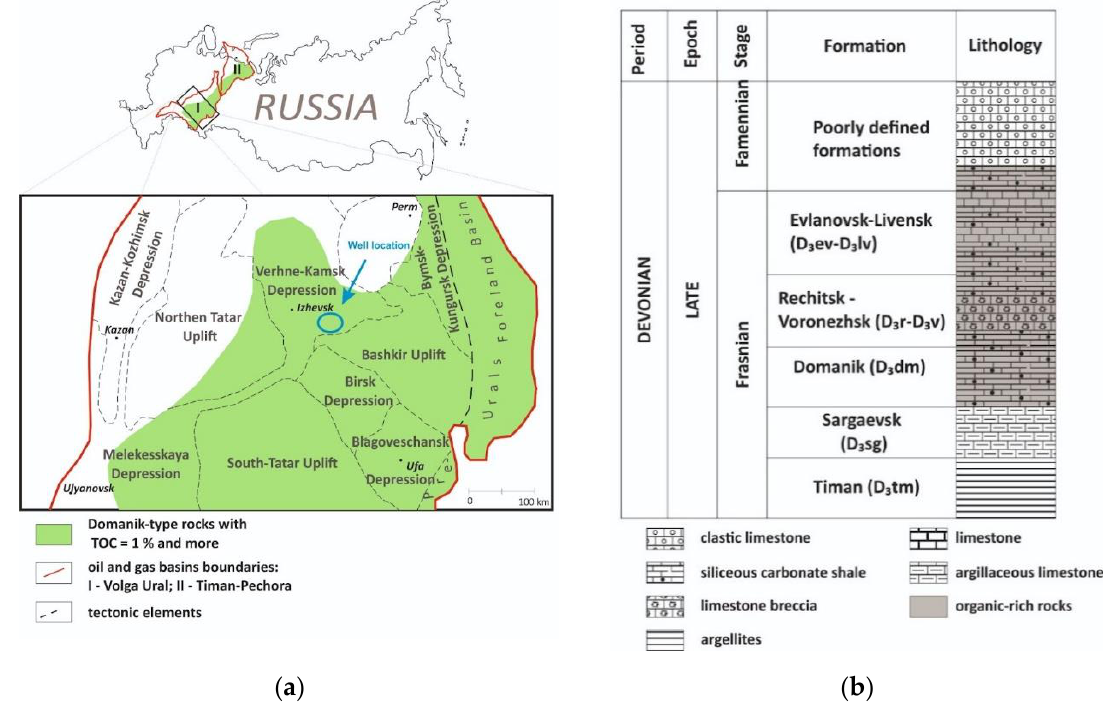
Figure 1. ( a ) The geographic location of the Domanik-type rocks; ( b ) the Domanik Formation in the regional stratigraphic chart.